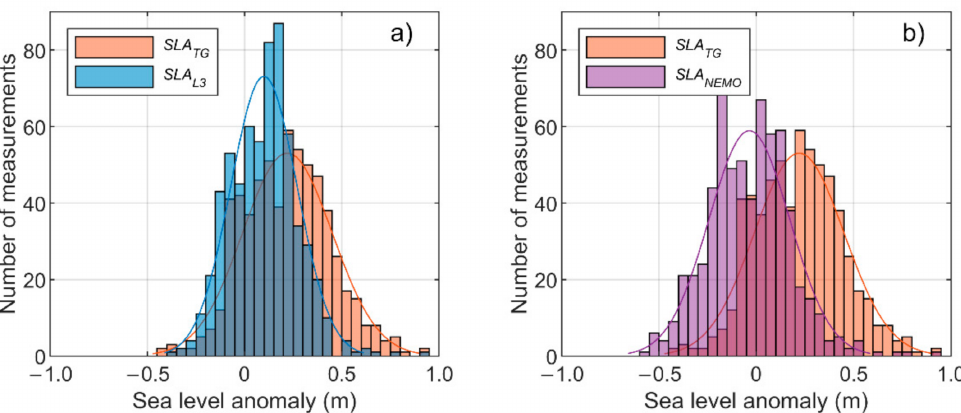
Figure 13. Sea-level anomaly frequency distribution (and their overlaps) calculated with a bin size of 0.05 m for ( a ) SLA TG and SLA L3 and ( b ) SLA TG and SLA NEMO in the Baltic